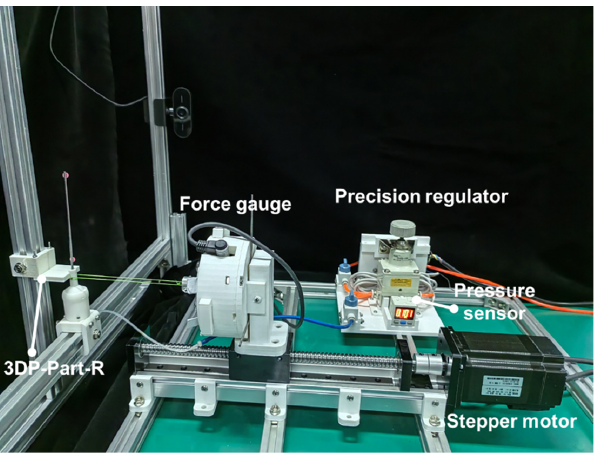
Figure 8. The experimental setup for testing the rotational stiffness of the VSBJ. During the experiments, the soft pneumatic elastomer actuator was inflated with dif- ferent constant pressures (6 kPa, 100 kPa, 200 kPa, 300 kPa and 400 kPa, respectively). For each input air pressure, the inner ball of the VSBJ was rotated ranging from 0 to 20 degrees by the force gauge through the linear motorized module at 1.25 mm/s constant speed. Fr was the applied pulling force along the X-axis perpendicular to the rod of the inner ball in the initial state, as illustrated in Figure 9a. The distance from the point of application of the pulling force to the center of the ball was 18 mm. The test for each input pressure was repeated five times. The pulling force with respect to the rotational angles was recorded and the obtained data were converted into torque by equation (1). The mean value (solid line) and standard deviation (shaded area) of the external torque that the VSBJ can with- stand in the rotational direction at different input air pressures were illustrated in